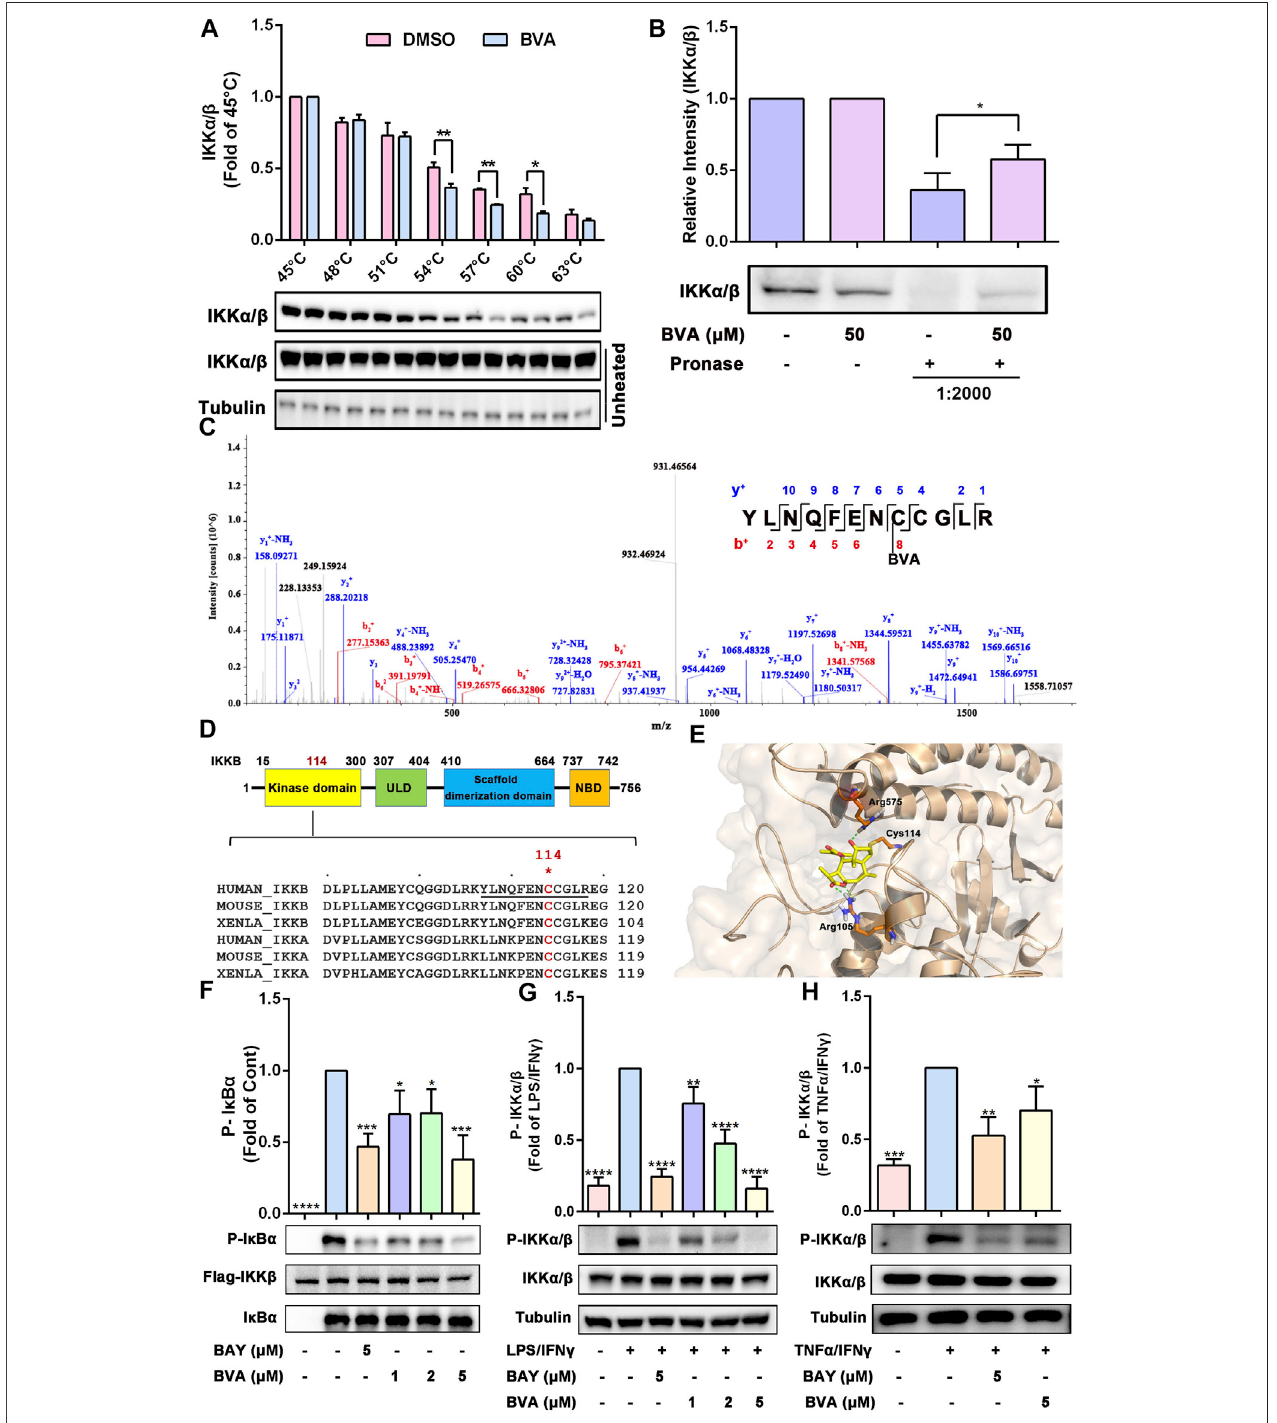
FIGURE6| BrevilinAdirectlybindsIKK α / β toinhibiting theiractivation. (A) Theeffects ofBVA onthethermalstability ofIKK α / β wasanalyzed byCETSAassay.The top panel shows thequanti fi cation ofthethermalstabilityofIKK α / β in different temperature. Theopticaldensity ofIKK α / β wasnormalizedwith respect tothoseobtained at45 ° C. (B) TheeffectsofBVAontheproteolyticsusceptibilityofIKK α / β wasanalyzedbyDARTSassay.ThedensitometryanalysisofIKK α / β wasshown. (C) LC-MS/MS analysis of the recombinant human IKK β protein incubated with BVA for 8 h at 4 ° C. The covalent binding site is shown. (D) The top panel shows the schematic diagram of domains in IKK β . The bottom panel shows the sequence comparison analysis of IKK α / β from different species and the Cys114 is highlighted in red. (E) MoleculardockingofBVAwithIKK β (PDB:3RZF).Thecovalentbondandhydrogenbondareshown. (F) Puri fi edhumanFlag-IKK β